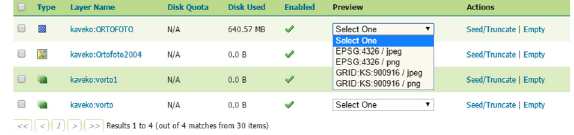
Figure 13. Layers offered through WMTS service